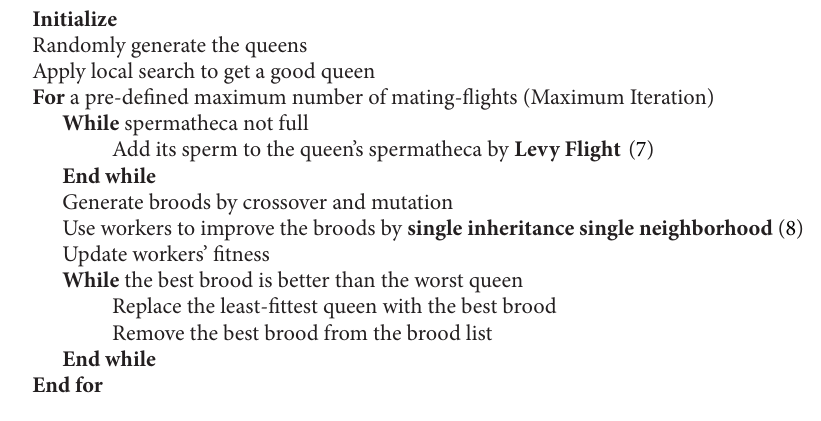
Algorithm 2: Proposed IMBO algorithm.